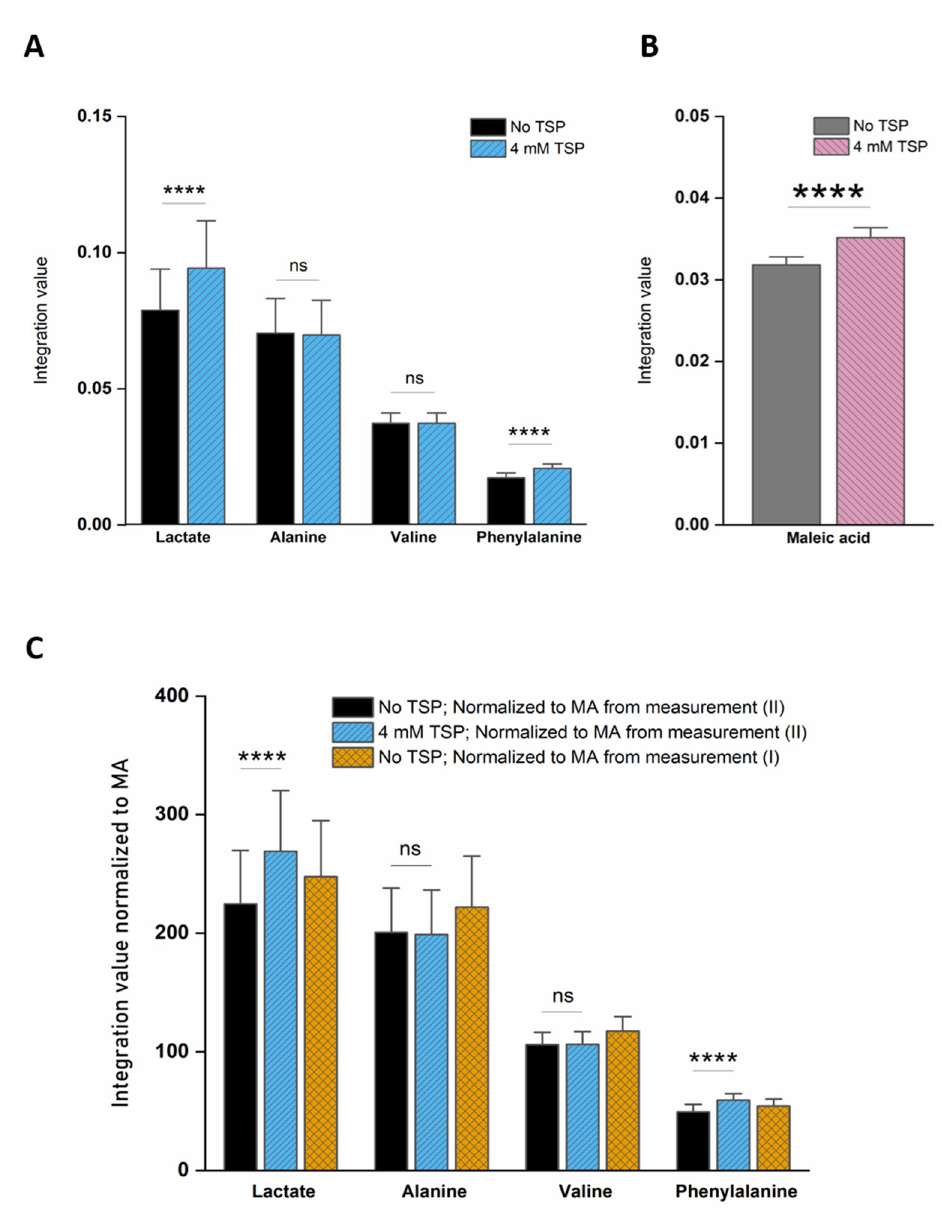
Figure 1. Non-IS-normalized integration values with standard deviation (from 12 different plasma samples) for ( A ) lactate, phenylalanine, alanine, and valine and ( B ) maleic acid in human plasma samples without (I; black bars) and with 4 mM TSP (II; blue bars). Measurement (I) was immediately followed by measurement (II) under fully identical measuring conditions. Whereas the integration value for alanine and valine signals remains unchanged after TSP addition, the integration values increase significantly for lactate, phenylalanine, and maleic acid. ( C ) Integration values of measurement (I) can be overestimated or underestimated when normalized towards MA without addition of TSP (yellow bars) because several metabolites as well as MA itself bind to HSA. Correct MA-normalized integration values for all metabolites are only obtained when 4 mM TSP is present (blue bars). MA: maleic acid; ns: not significant; TSP: trimethylsilyl-2,2,3,3-tetradeuteropropionic acid; (**** p < 0.0001).